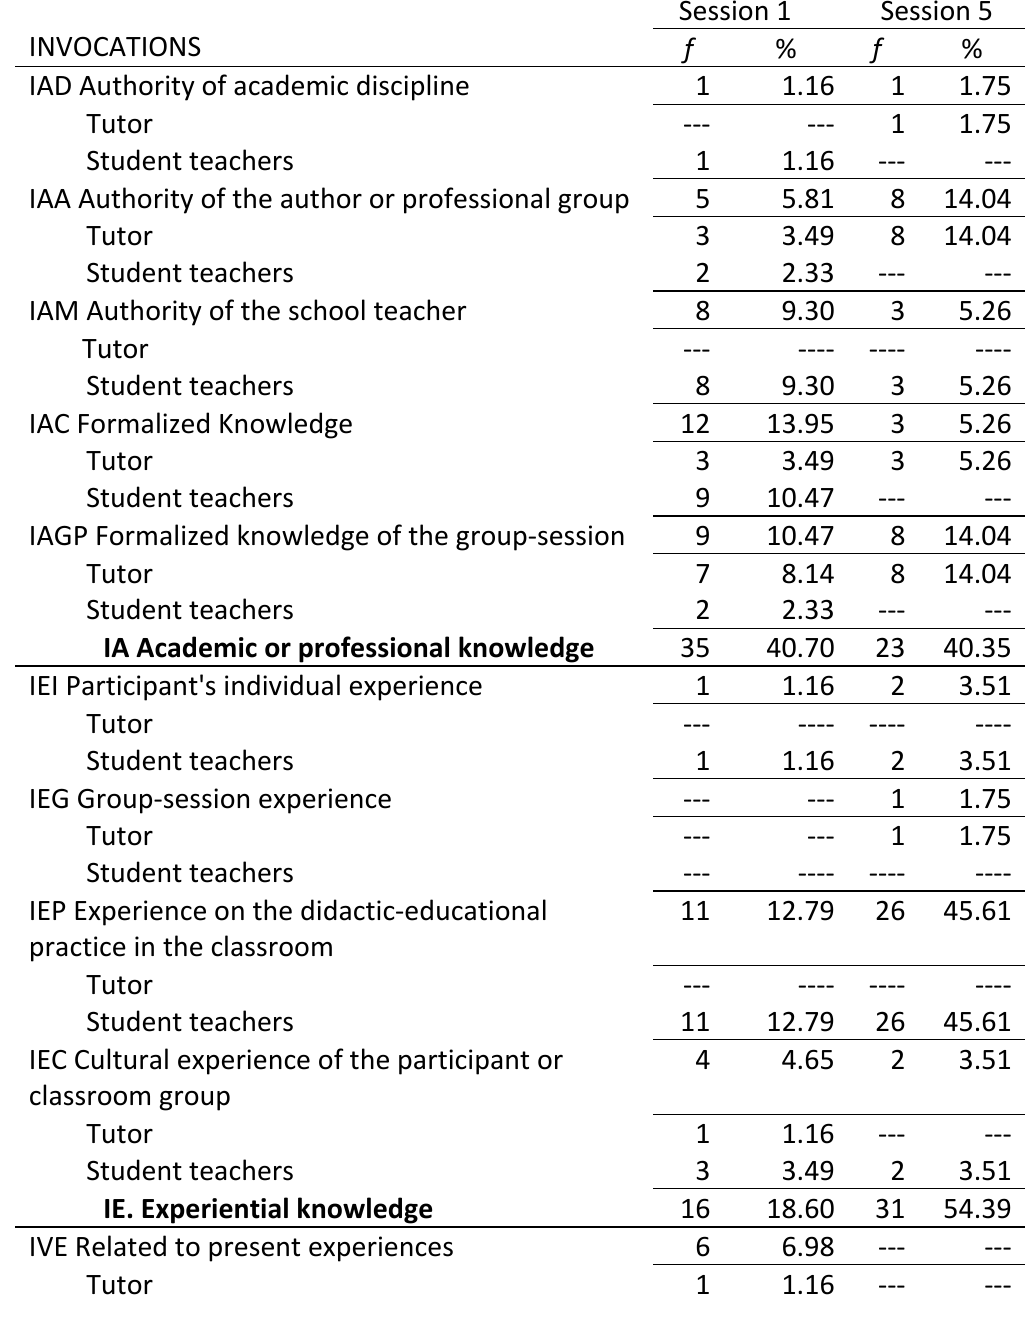
Table 5. Profile of invocations according to the session and the agent for case